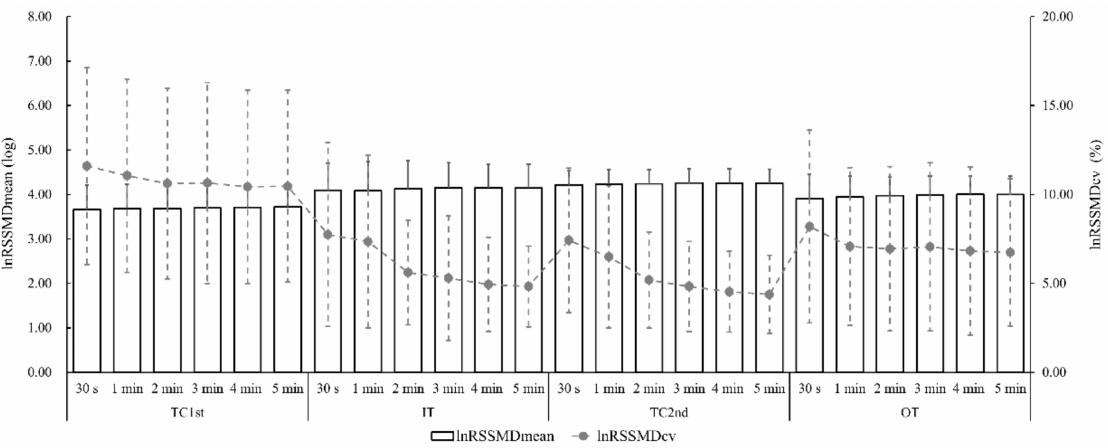
Figure 1. Mean and standard deviation of average (LnRMSSD mean ) and coe ffi cient of variation (LnRMSSD cv ) of natural algorithm of root mean square of successive R-R intervals in first training camp (TC 1st ), invitation tournament (IT), second training camp (TC 2nd ), and o ffi cial tournament (OT). Ultra-short-term (30 seconds and 1 minute) and short-term (2 minute, 3 minute, 4 minute, and 5 minute) records are presented in each study period.